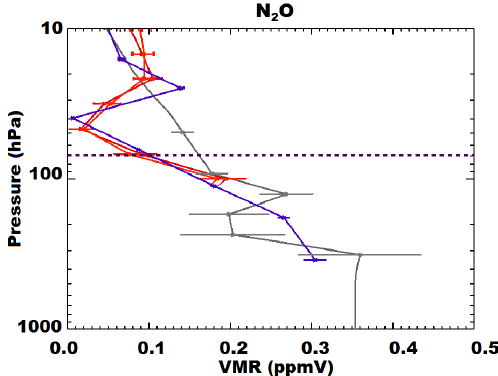
Fig. 14. Comparison of N 2 O profile retrieved from MARSCHALS scan 10 (grey) with MIPAS/ENVISAT (blue) and MLS/Aura (red) N 2 O profiles. The horizontal dashed line represents the flight alti- tude